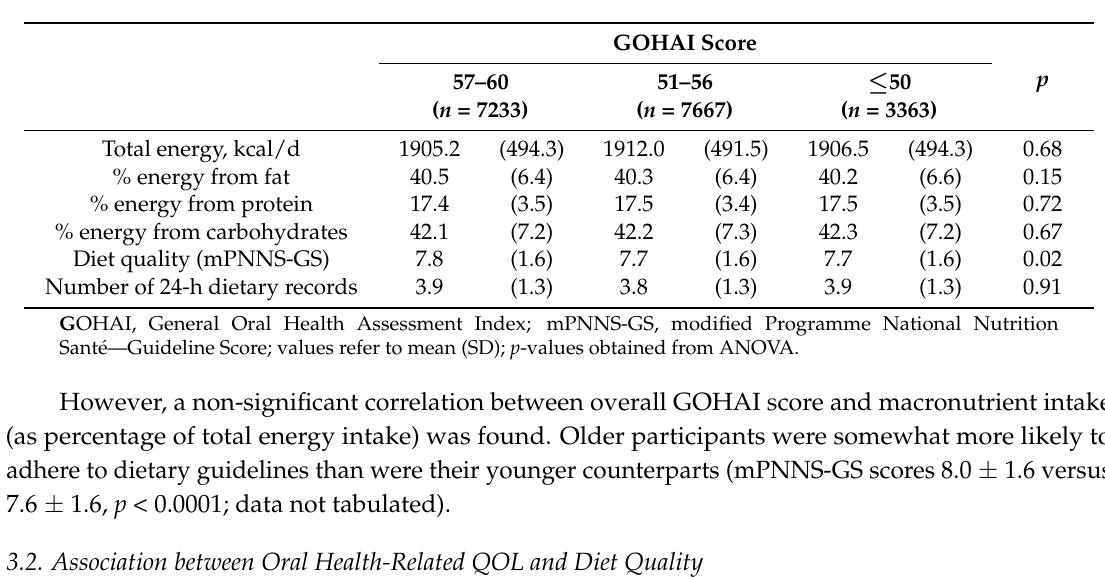
Table 2. Dietary intake and diet quality by overall GOHAI score (Etude NutriNet-Sant é , N = 18,263).